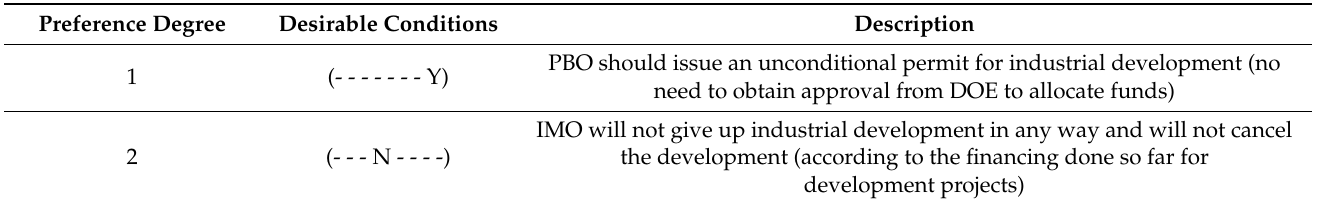
Table 7. PBO preferences (in order from most desirable to most undesirable